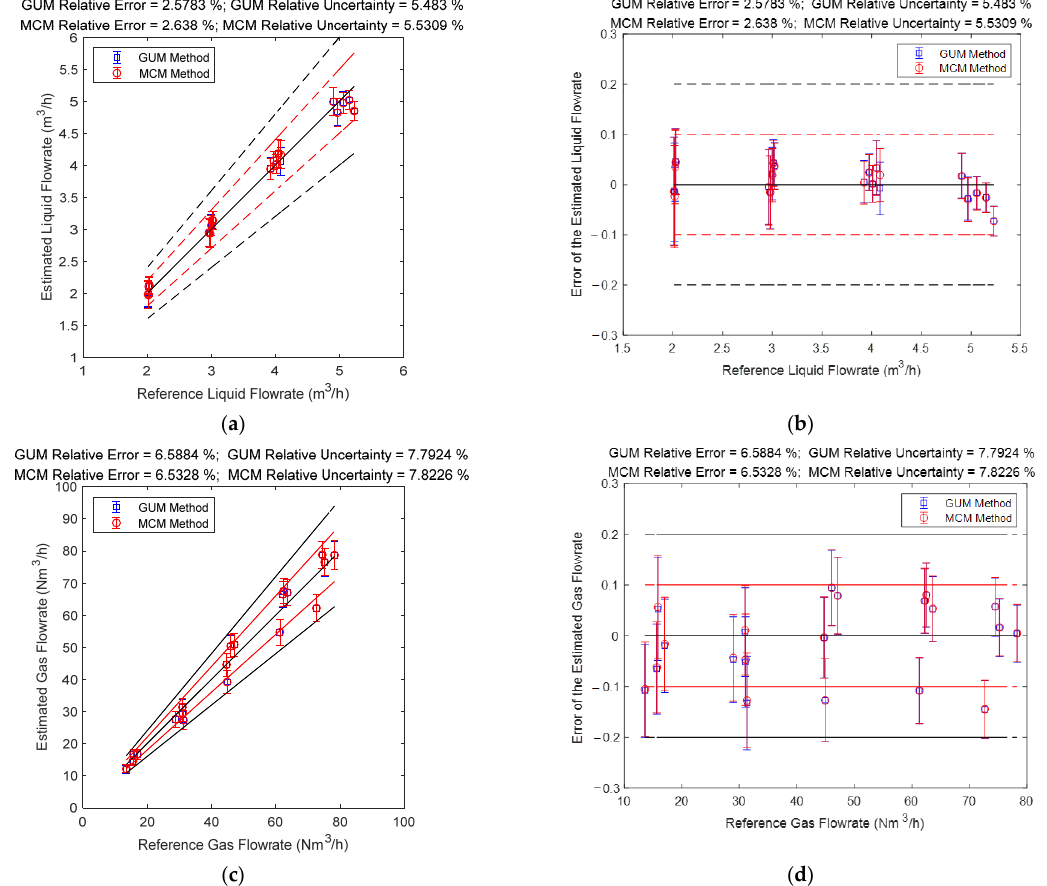
Figure 22. The prediction results of the gas and liquid flowrates of the multi-sensor fusion algorithm: ( a ) absolute error of the liquid flowrate; ( b ) relative error of the liquid flowrate; ( c ) absolute error of the gas flowrate; ( d ) relative error of the gas flowrate. (The central black line denotes the ideal case with zero error, the upper and lower red lines denote the 10% relative error range, and the upper and lower black lines denote the 20% relative error range. The line segments denote the standard uncertainty whereas the distance between the point and the central black line denote the error. More information can be found in Section 2.4.2).